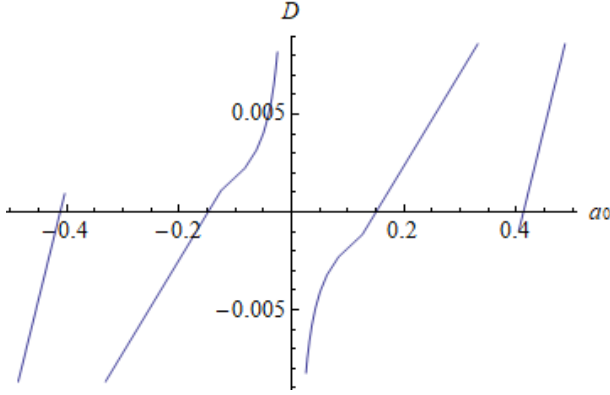
Figure 5. Variation of D with respect to amplitude a 0 for δ > 0 , given by Equatiuon (77).